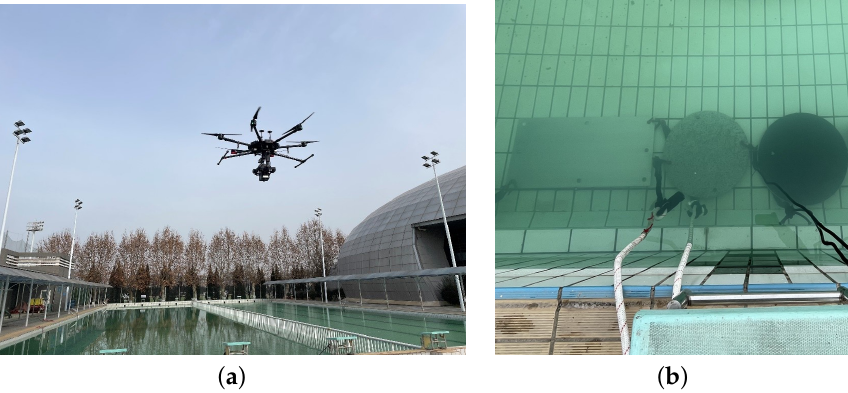
Figure 2. Photos of the experiment site. ( a ) UAV carrying Gaia Sky-mini3 hovering above the pool. ( b ) Targets placed at 0.89 m